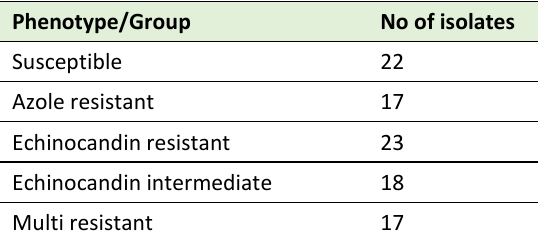
TABLE 2. Categorization of the isolates analyzed in this study according to their susceptibility